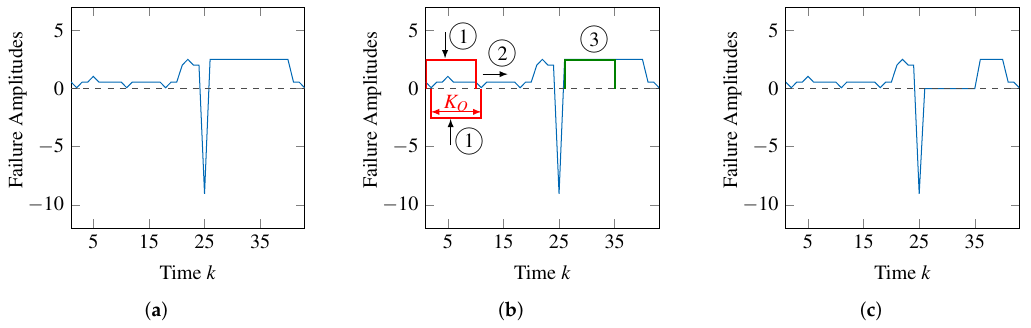
Figure 8. Steps for identifying failure types within the first phase of the processing chain. ( a ) initial failure amplitudes f p k , o k q ; ( b ) step 2 for identifying failure types; ( c ) step 4 for identifying failure